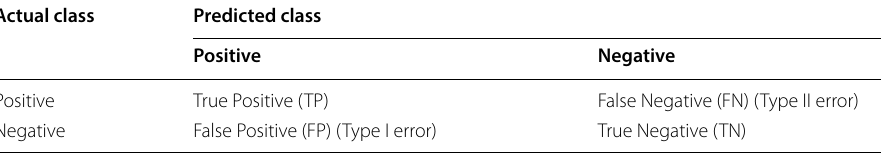
Table 1 Confusion